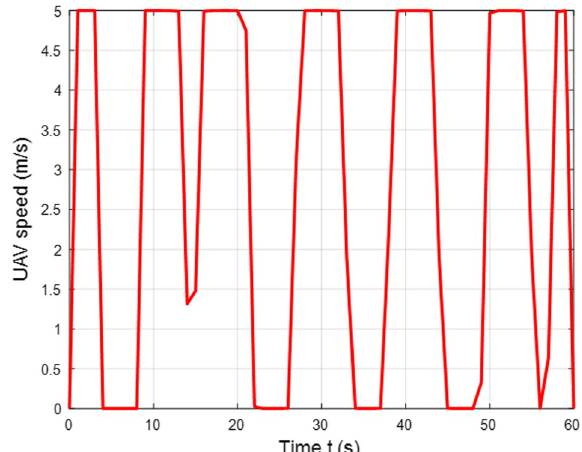
Fig. 3 The UAV speed versus time for T = 60 s